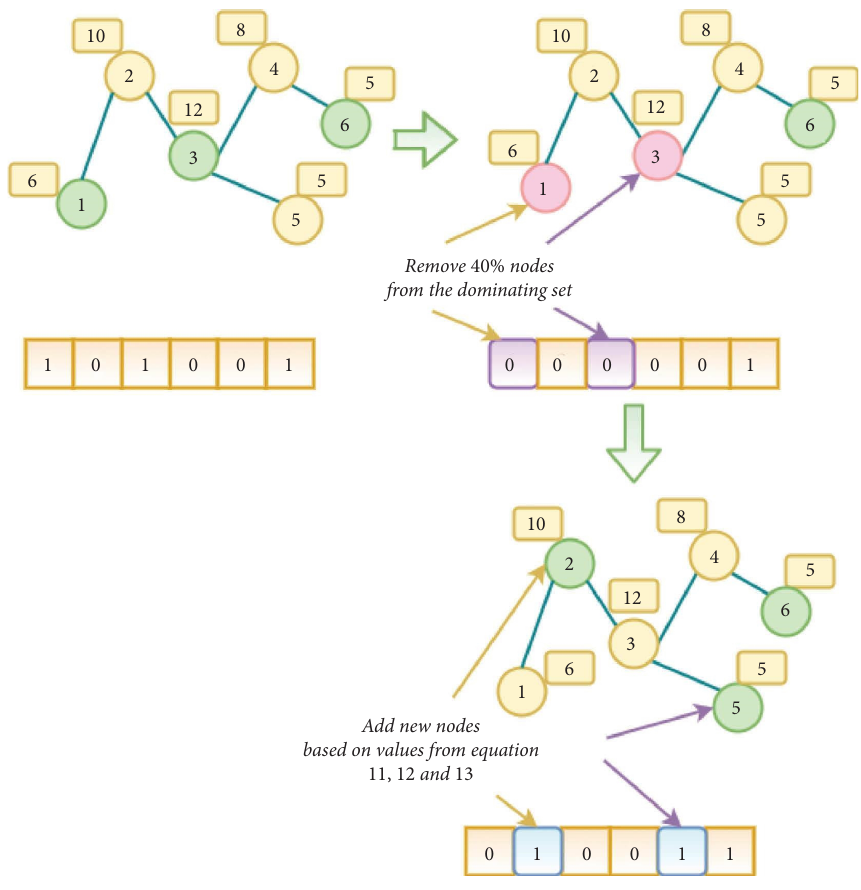
Figure 10: Illustration of repair